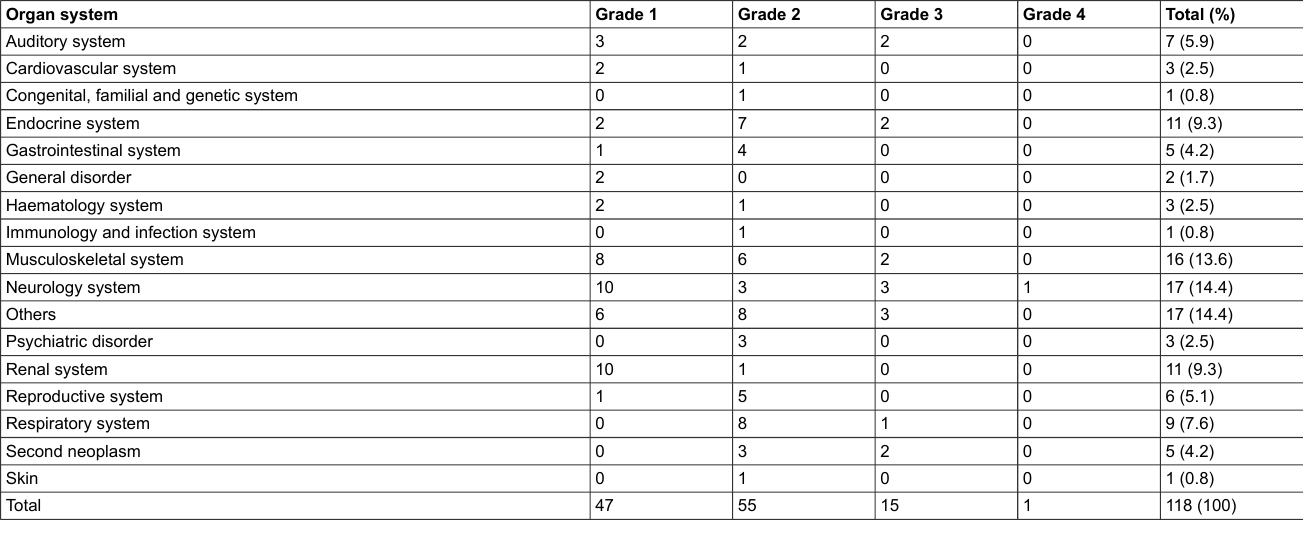
Table 2: Number of chronic health conditions by organ system according to the CTCAE grade scale. Organ